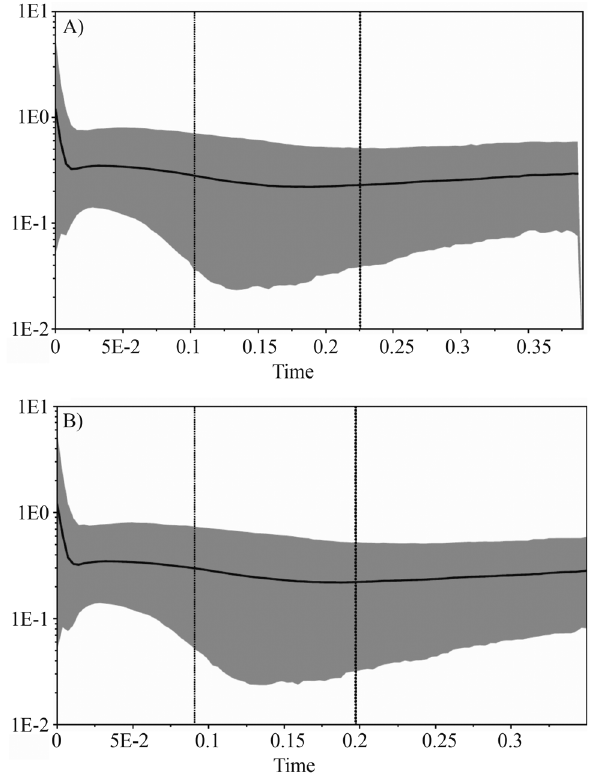
Figure 4 - Bayesian Skyline plots derived from an alignment of puma ND5 sequences. In (A) the analysis was run for all puma samples, and in (B) for South American pumas only. The thick solid line represents the mean, while the 95% HPD (highest posterior density) limits are shown by theblueareas.Theverticaldashedlinesrefertothe t MRCA ,withthethinline indicating the lower 95% HPD limit, and the thick line representing the mean. The x-axis is depicted on a scale of millions of years (myr). The y-axis represents the effective population size (N e ) multiplied by the gen- eration time (also in myr). Assuming a generation time of 5 years, the numbersonthisaxisshouldbemultipliedby200,000toyieldinterpretable